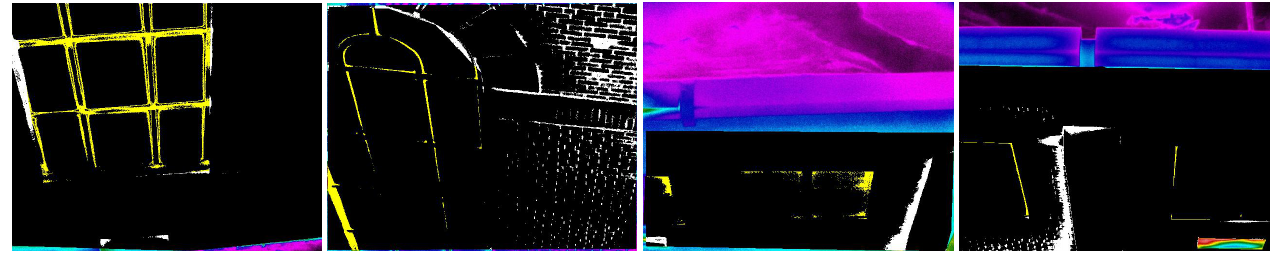
Table 7. Hotspot pixel overlapping (%) for windows and walls.